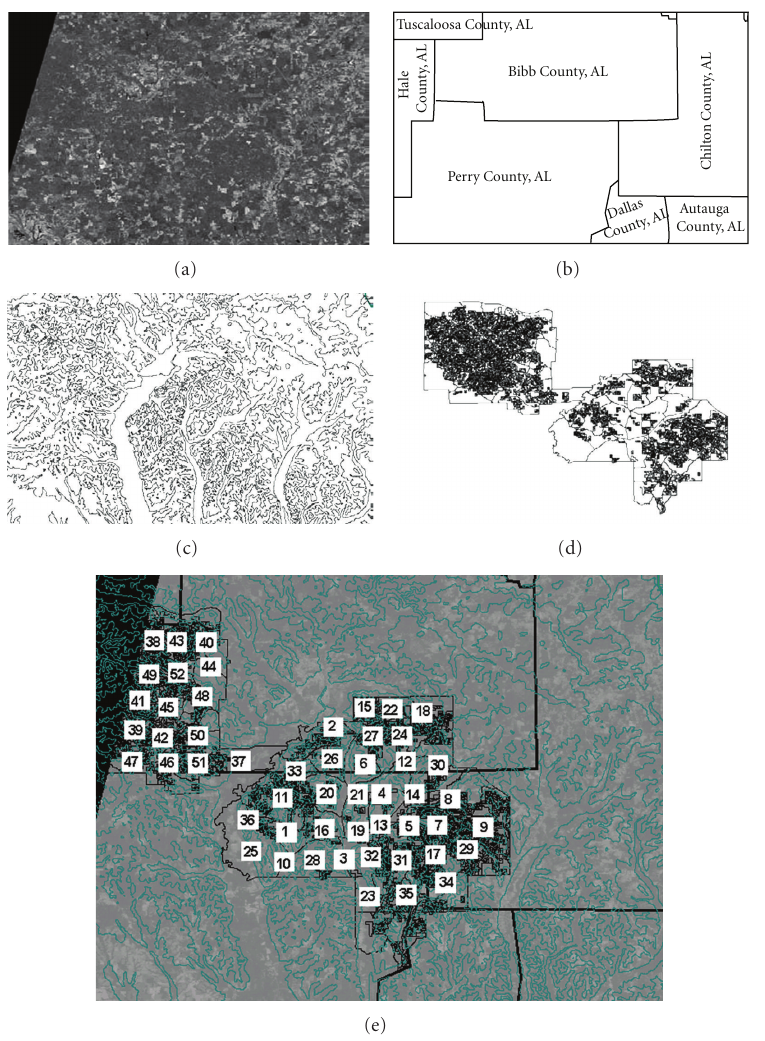
Figure 5: Overlaying and sampling process for Oakmulgee National Forest: (a) Landsat TM image, (b) counties, roads, and city locations (c) DLGs, (d) forest stands, and (e) overall layers and